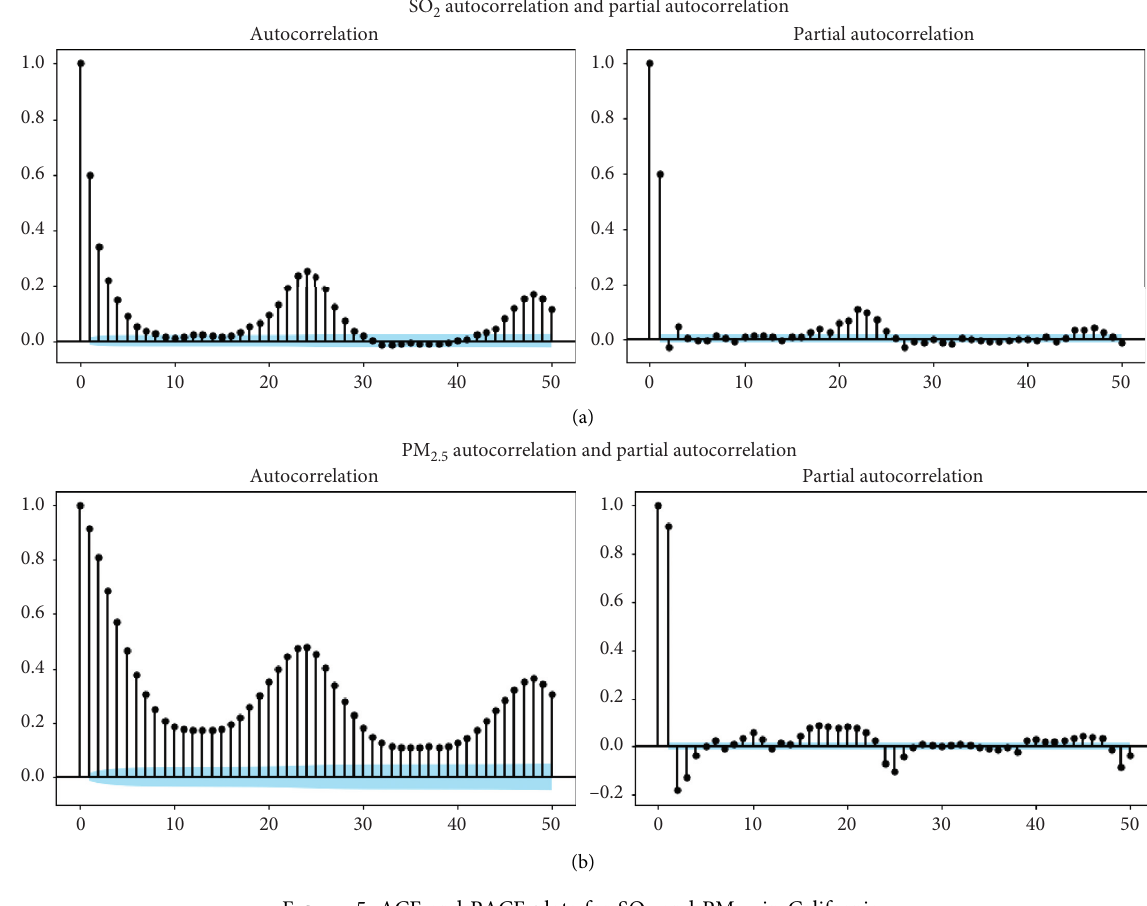
2 and PM 2.5 in California.